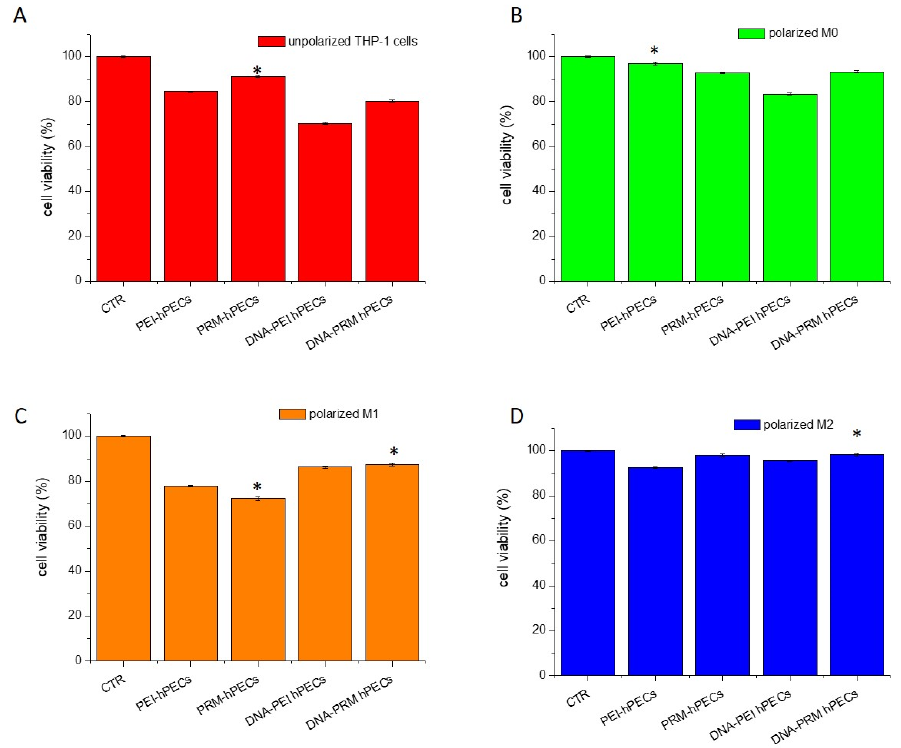
Figure 4. MTT assay on THP-1 cells after 24 h of incubation with different hPEC formulations without polarization ( A ), after M0 polarization ( B ), after M1 polarization ( C ), and after M2 polarization ( D ). Representative measurements of three distinct sets of data. * indicates p -values of <0.05 for Student’s t -test.